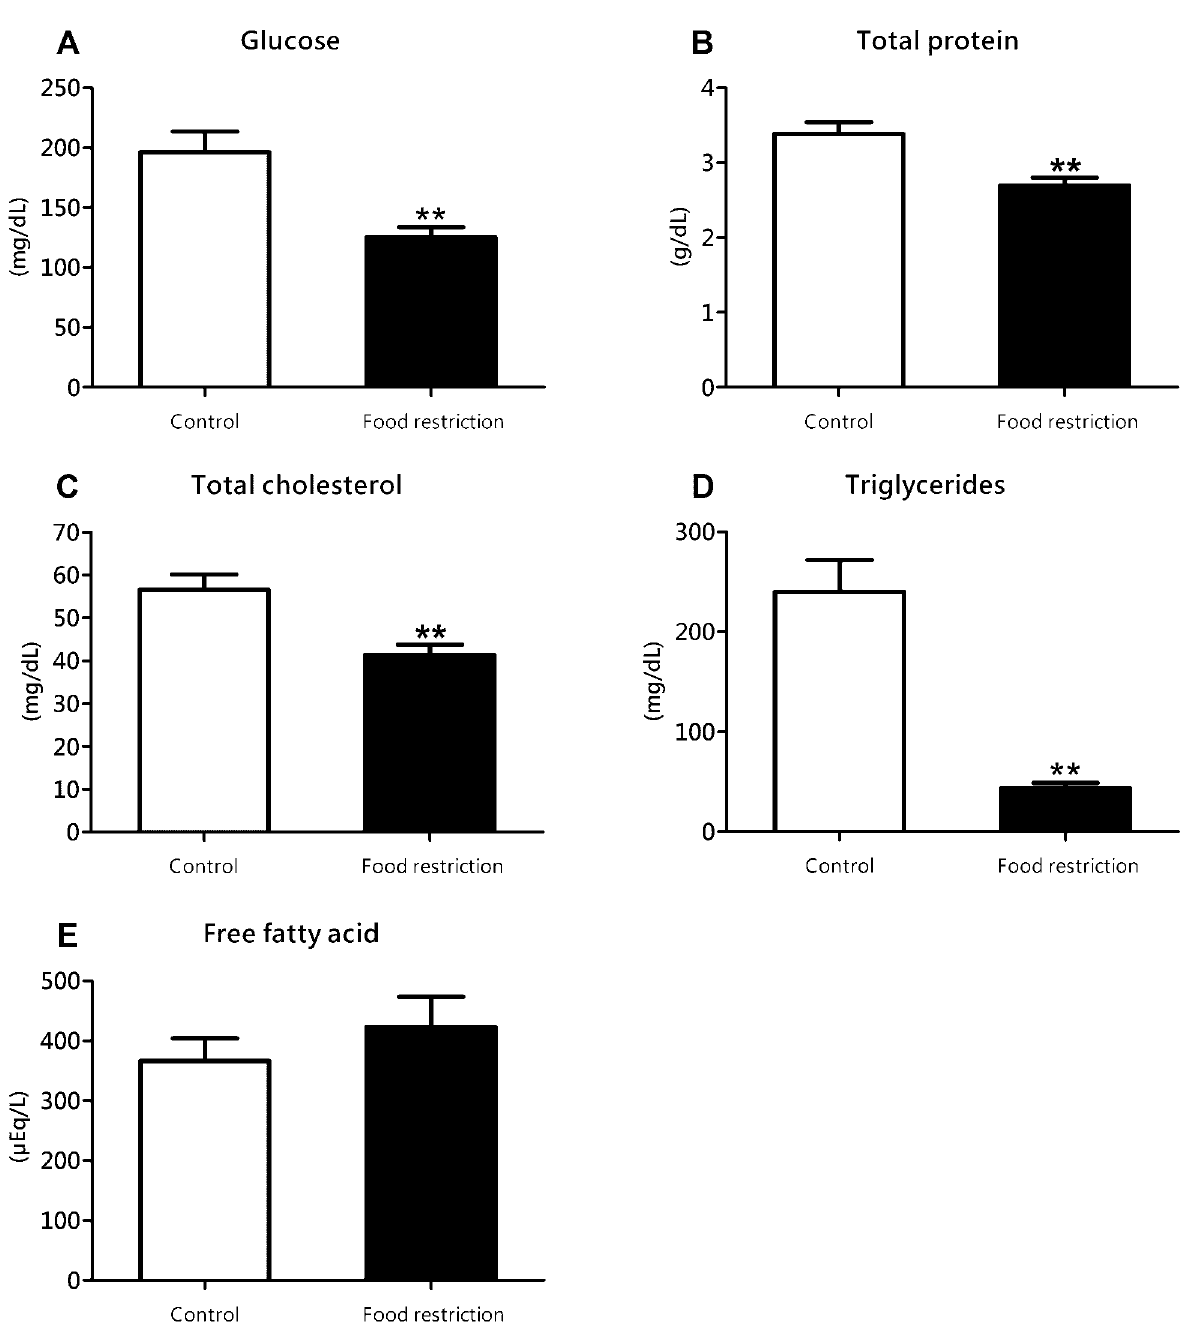
Figure 4. Serum concentration of glucose (Figure 4A), total protein (Figure 4B), total cholesterol (Figure 4C), triglycerides (Figure 4D) and free fatty acid (Figure 4E) determined at the end of the experiment for control and food restriction groups; ** P<0.01 in relation to control